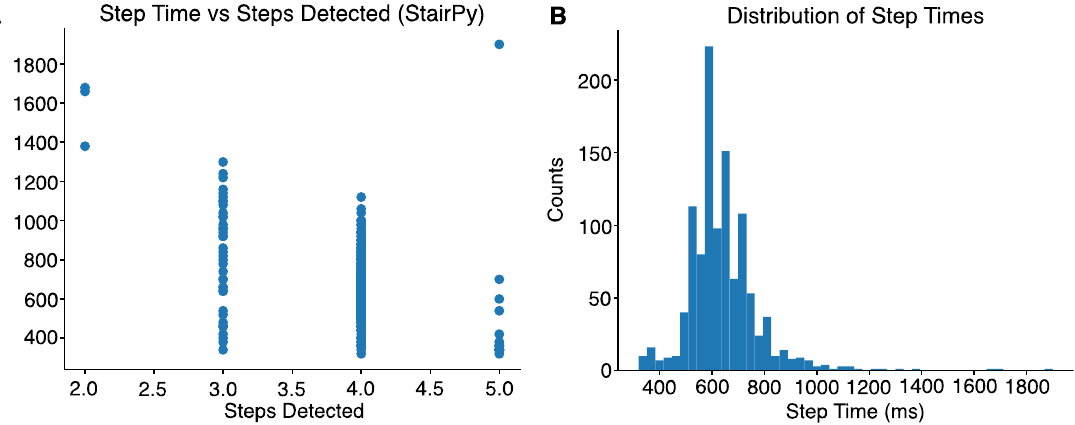
Figure 2. ( A ) Steps greater than 1200 ms (1.2 s) were misidentified as either 2, 3, or 5 total steps and ( B ) Distribution of step times across participants.